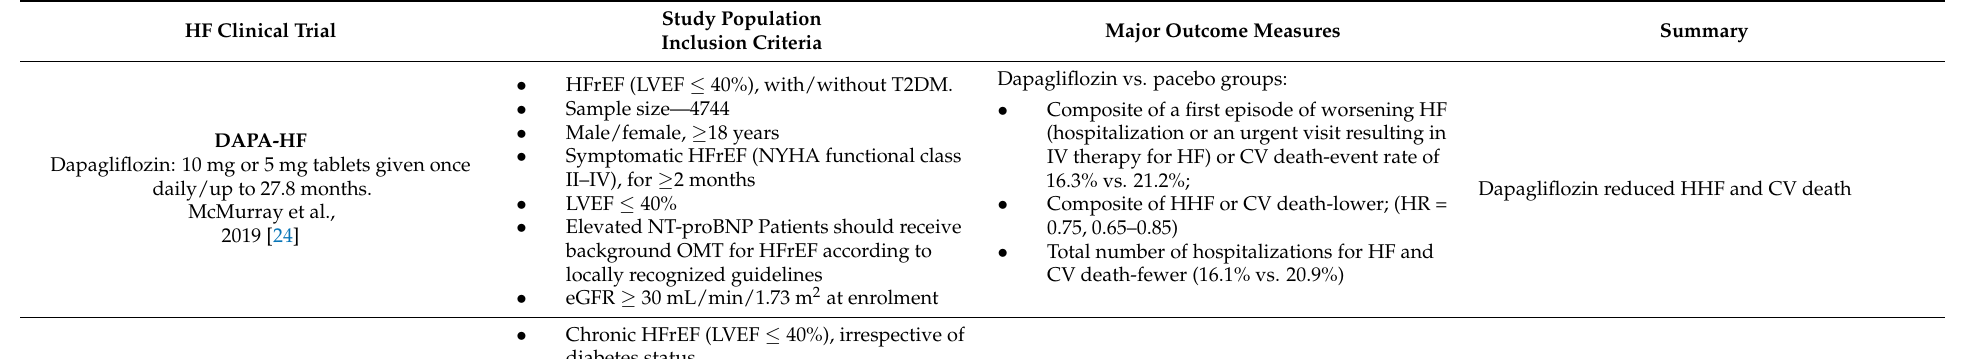
Table 1. SGLT-2i treatment outcome in primary HFrEF clinical